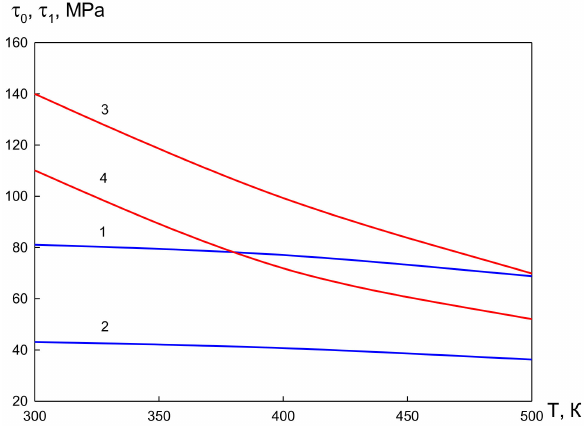
Figure 3. Temperature dependencies of yield stress, τ 0 (blue curves 1 and 2), and hardening stress, τ δ , and distance between particles, Λ p , on curves 1 and 3 are, 1 (red curves 3 and 4). Particles diameter, respectively, 10 and 100 nm, and on curve 2 they are 20 and 200